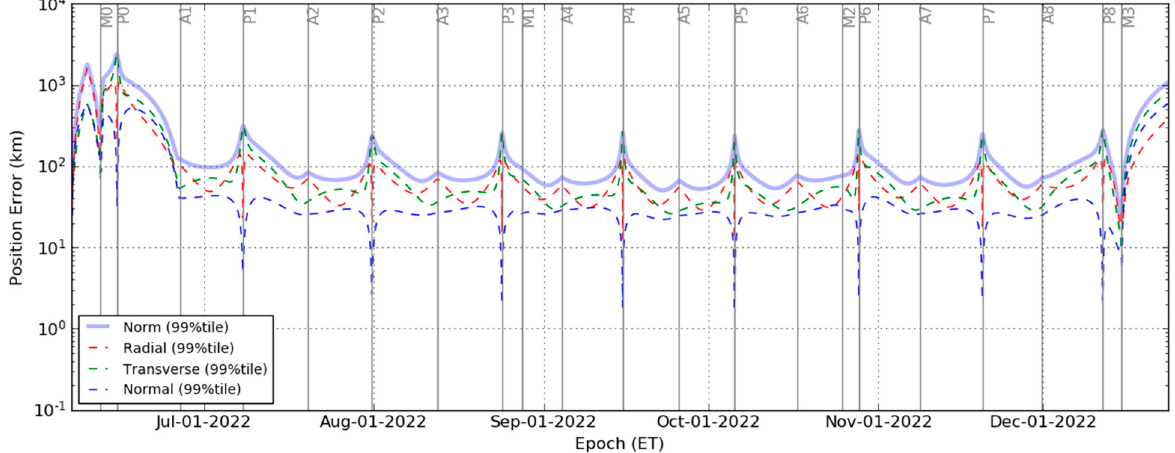
Figure 8. Controlled trajectory 99th percentile dispersion through the whole mission using the nominal control strategy. The error is computed with respect to the reference trajectory using the geocentric RTN